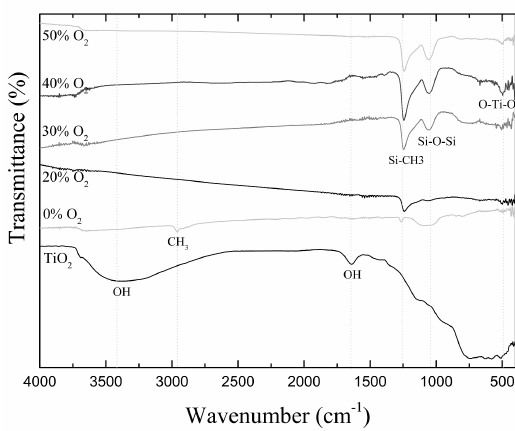
Figure 6. Transmission infrared spectra of the films deposited with different percentages of oxygen in the feed. The spectrum of TiO (P25 Evonik) is also shown.